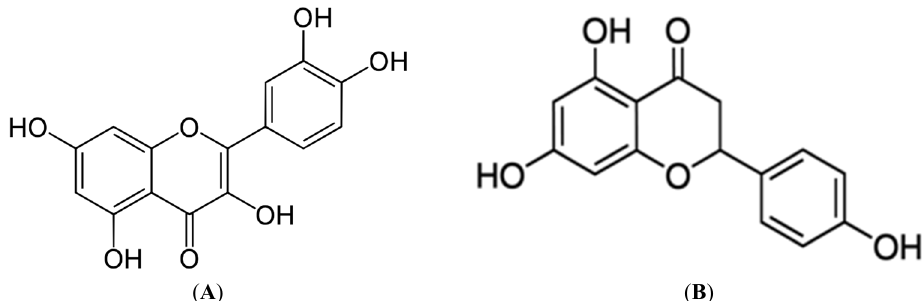
Figure 4. The chemical structure of quercetin ( A ) and naringenin ( B ). These polyphenols are predominant in vegetables, fruits, coffee, and tea in the form of a glycoside [53,54].